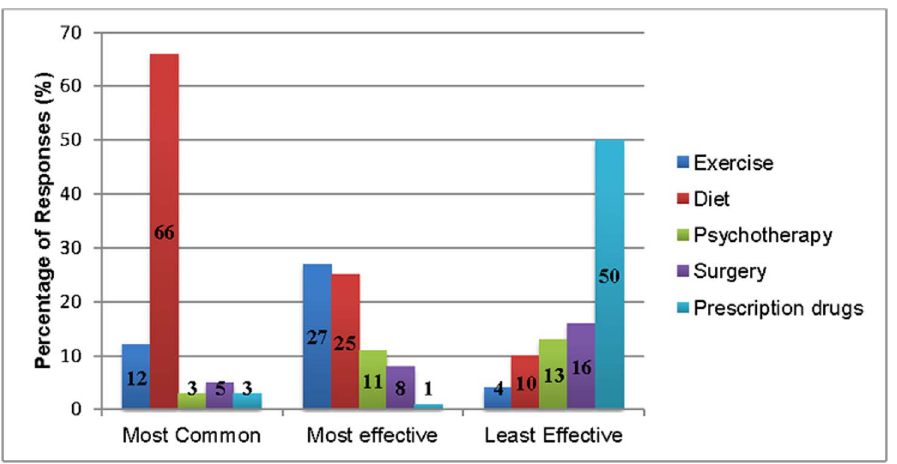
Figure 2. Proportion of responses based on most common, most effective, and least effective treatments of obesity.